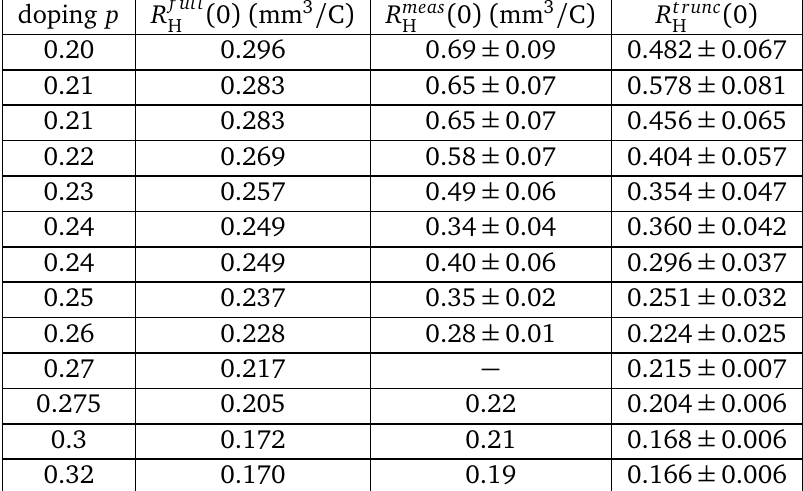
Table 11: Measured Hall coefficient R meas on Table 8) for OD LSCO together with R f ull assuming a fully coherent FS, and R trunc truncated FS within scenario I determined using n values listed in Table 10.